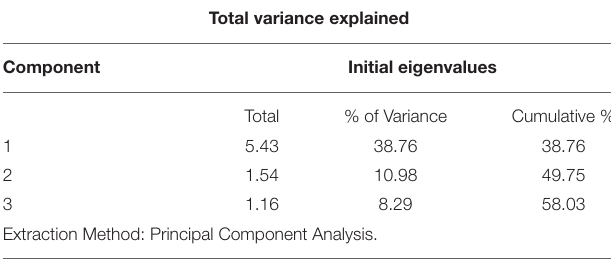
TABLE 4 | Attitudes about mental health as reported by swine veterinarians. TABLE 5 | Job satisfaction principal component